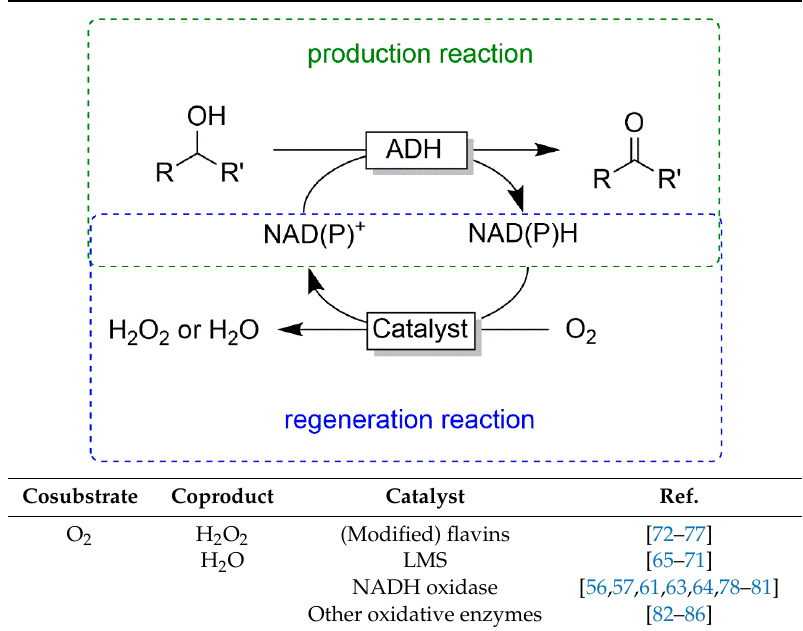
Table 1. Selection of aerobic NAD(P) + regeneration systems to drive ADH-catalyzed oxidation reactions.